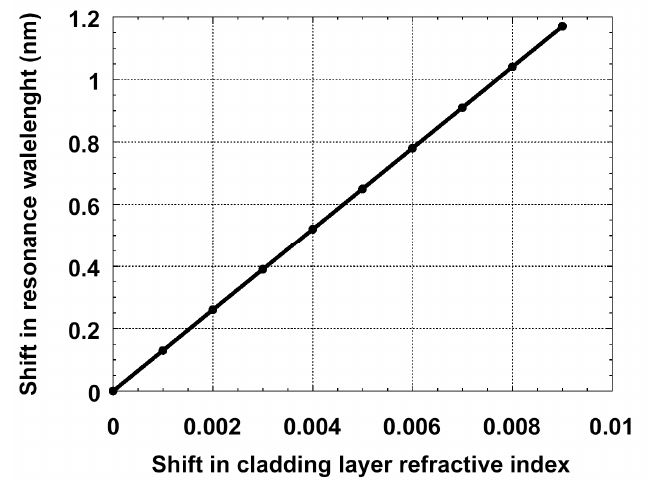
Figure 8 . Shift in resonance wavelength versus shift in cladding layer refractive